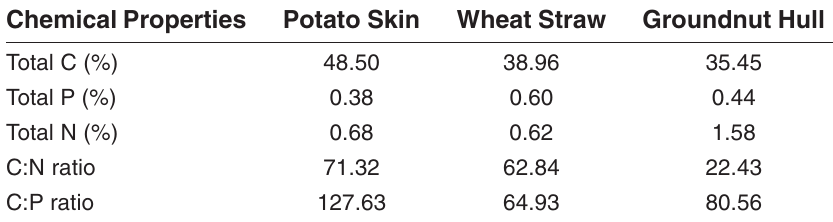
Results of Chemical Analysis of the Organic Residues Used for the